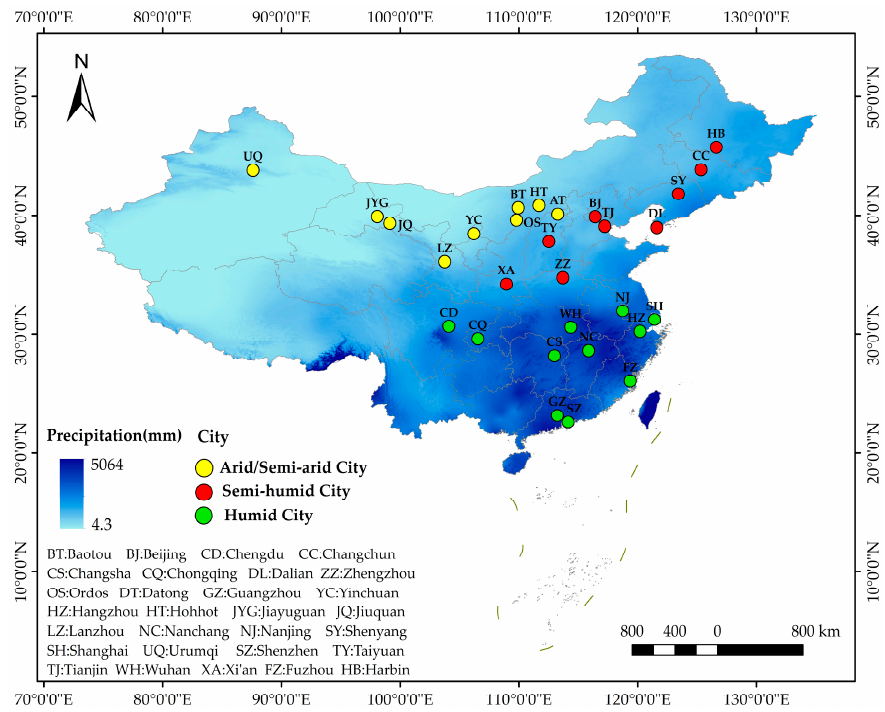
Figure 2. Locations of the 29 selected cities with three different climatic regions in China.